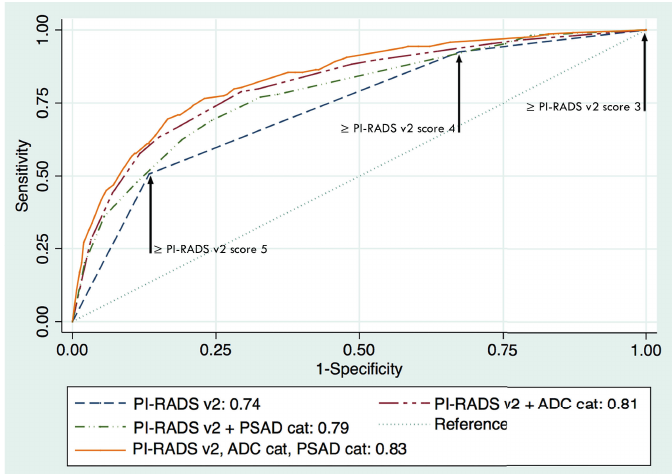
Figure 2 - Prediction of clinically signifi cant prostate cancer at targeted lesions, ROC curves. The greatest separation between the curve of the model that included only PI-RADS v2 scores and the other three models is seen in the segment that corresponds to PI-RADS v2 scores 4 and 5. The model that incorporated both categorized (cat) ADC values and PSAD provided better discrimination.